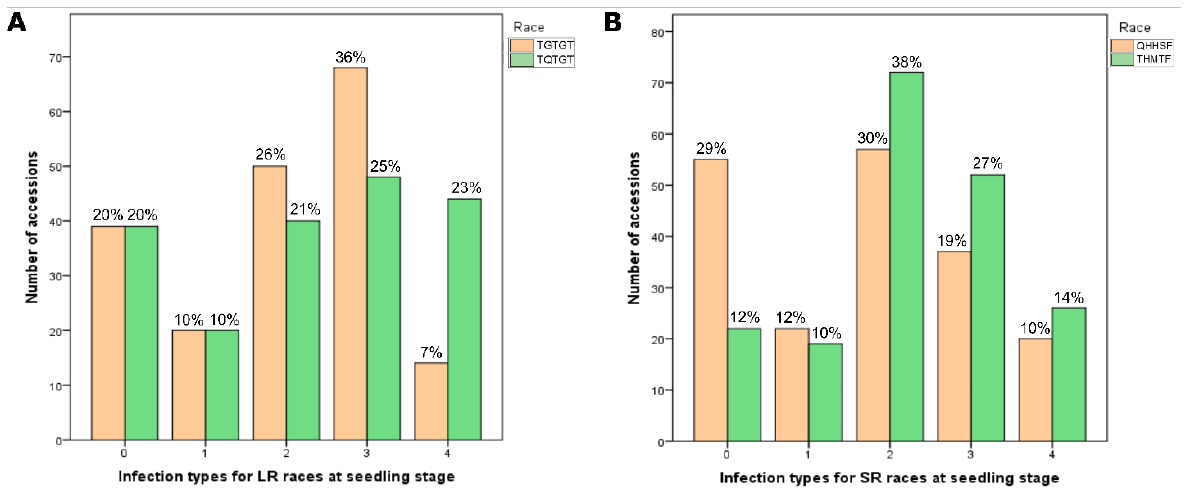
Figure 1. Summary of infection types among 193 tetraploid wheat cultivars and breeding lines infected with races of ( A ) Puccinia triticina Eriks. (LR) and ( B ) Puccinia graminis f. sp. tritici (SR) at the seedling stage.